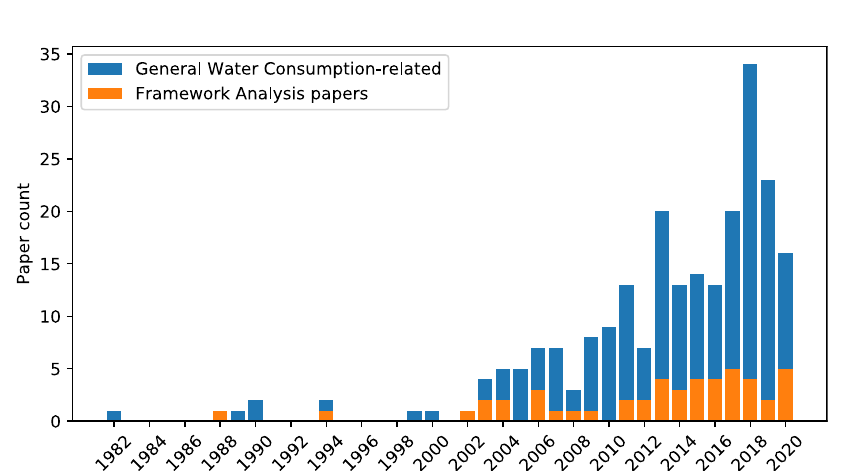
Fig. 3 Temporal development of the literature on the determinants of household water consumption. The yearly count of the 231 general water consumption-related (blue) and 48 framework analysis (orange) scienti fi c publications reviewed in this study is represented for the last forty